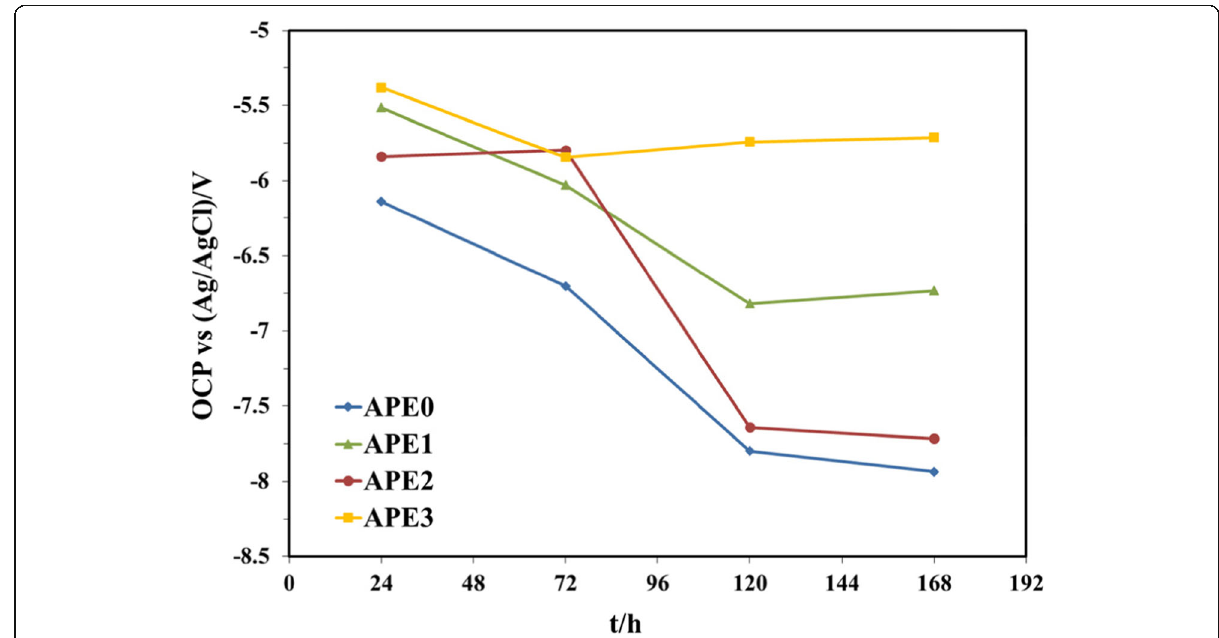
Fig. 2 OCP versus time for mild steel in NaCl brine containing 0 to 3% (v/v)